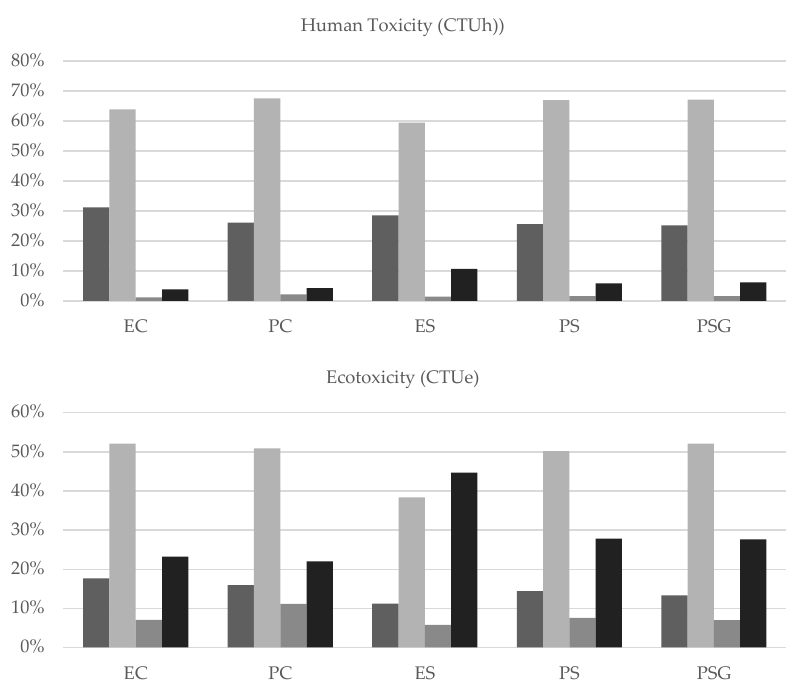
Figure 5. Contribution of each activity to the category of potential impacts: climate change, photochemical ozone formation, eutrophication, acidification, human toxicity, ecotoxicity. The sensitivity analysis regarding the productivity of the systems only influenced the transport activity. On average, the potential environmental impacts varied 24% in relation to the minimum and maximum volumes of wood produced. This proportion is significant since transport is the most impacting phase in the categories of photochemical ozone formation (45%), acidification (41%) and climate change (34%) due to the use of fossil fuels. Management influences the most the potential impacts of eutrophication (40%) due to the application of fertilizers, especially those containing